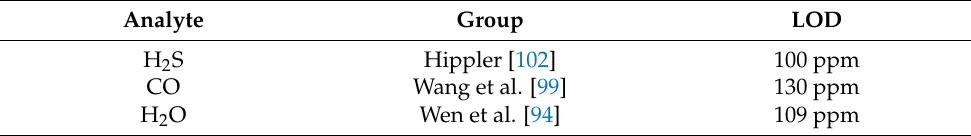
Table 7. Different analytes and their LOD for different CERS setups.